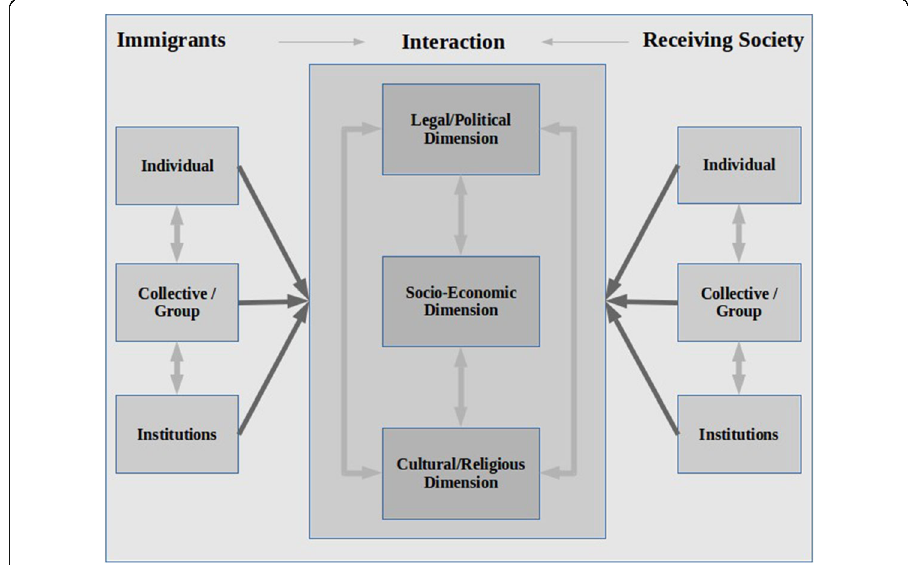
Fig. 2 Penninx and Garcés-Mascareñas ’ heuristic model for the empirical study of integration processes (2016). Source: Penninx and Garcés-Mascareñas (2016, p. 16 Fig.